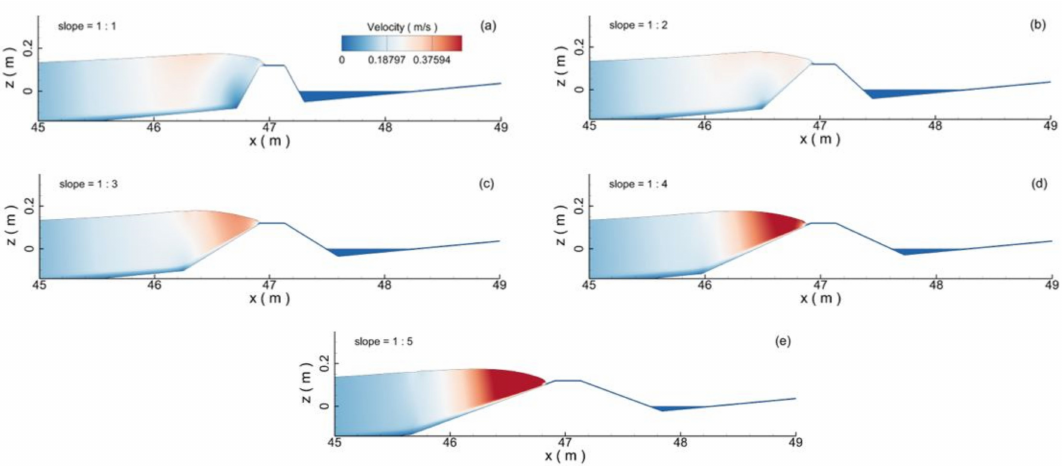
Figure 25. Snapshots of the velocity contours of the water body at the moment of the tsunami-like wave climbing over the seawall with different sidewall slopes; ( a ) side slope = 1:1; ( b ) side slope = 1:2;